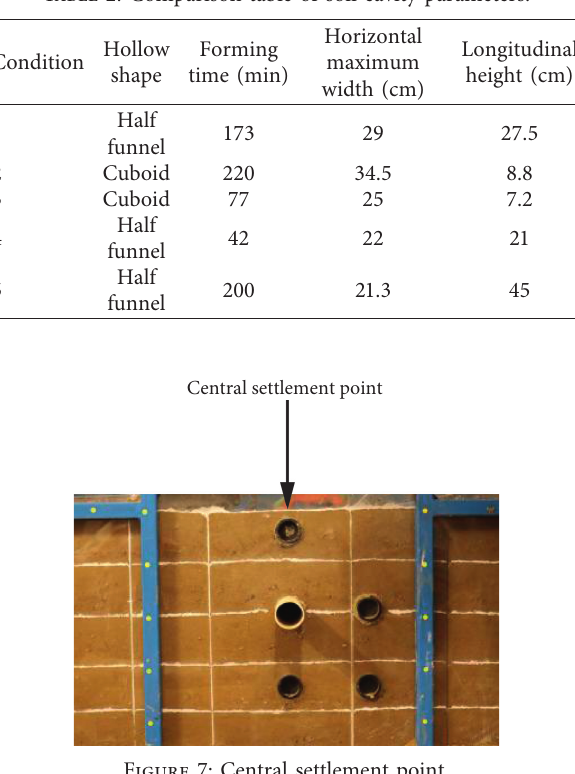
Table 2: Comparison table of soil cavity parameters.